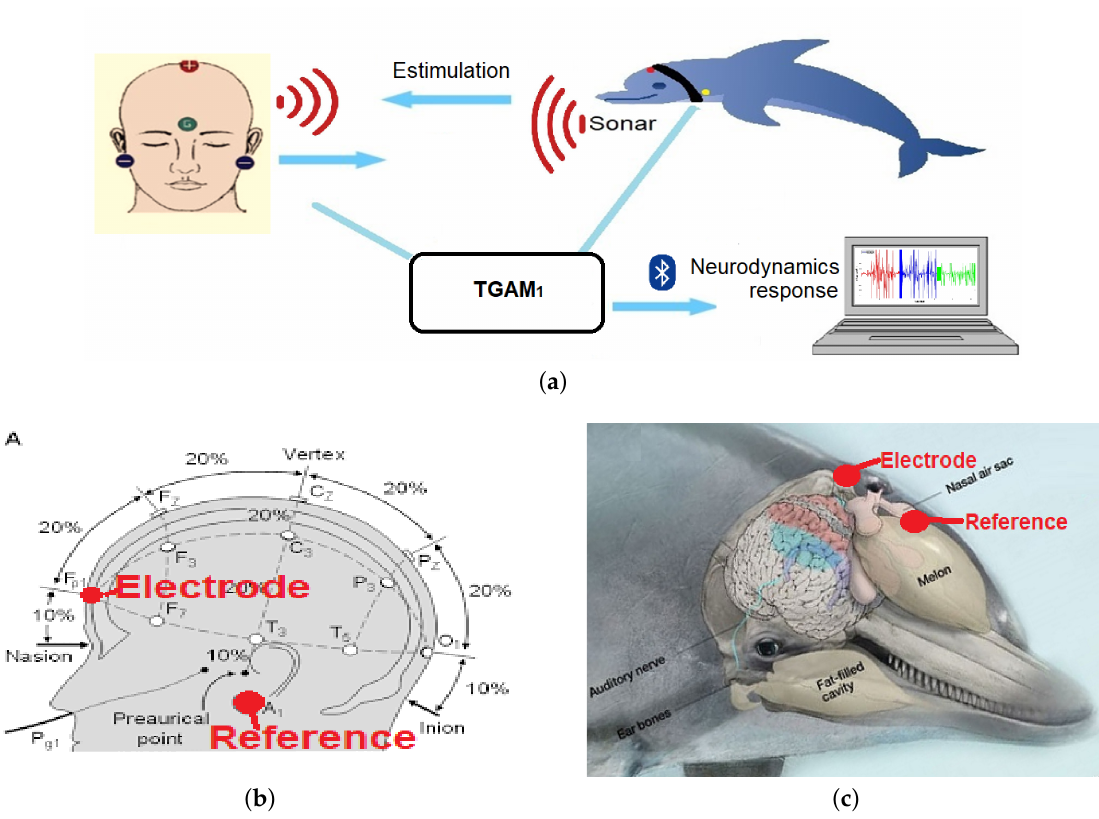
Figure 10. Design of the EEG interfaces: ( a ) general scheme. Placement of electroencephalographic systems: ( b ) EEG M and ( c ) EEG S